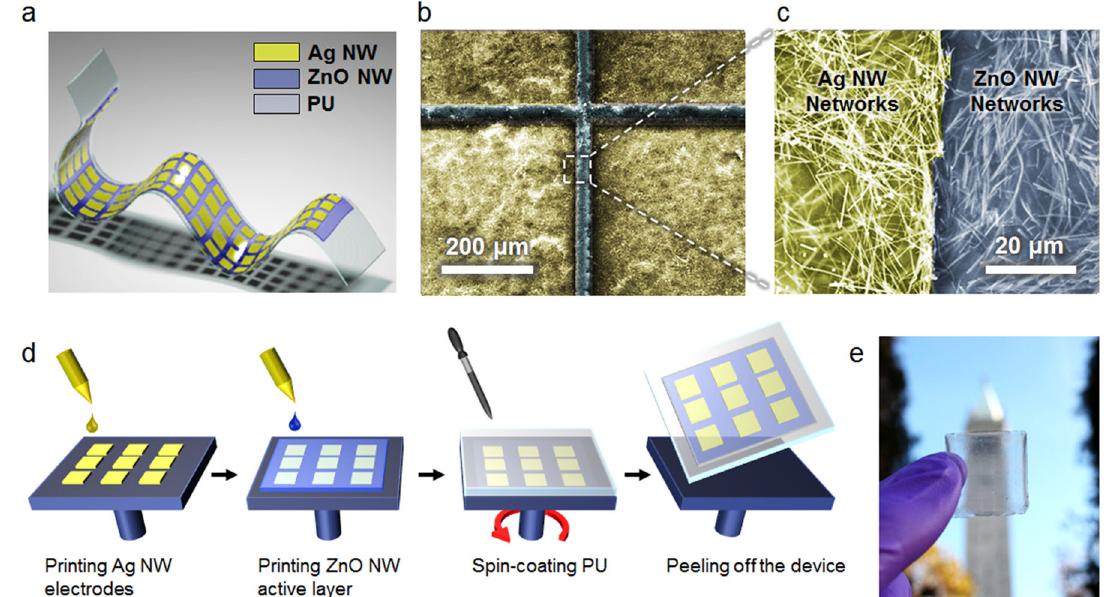
Fig. 1 a Schematic of an array of NW PD structures implanted into a fl exible TPU substrate. b Fabrication process of the NW PD device. c SEM image of the device geometry. The yellow region (false color) represents the Ag electrodes and the blue region represents the ZnO active material used for photodetection. d An enlarged view of ( c ) showing that both the electrodes and active materials are composed of a network of NWs. e A photograph of the transparent